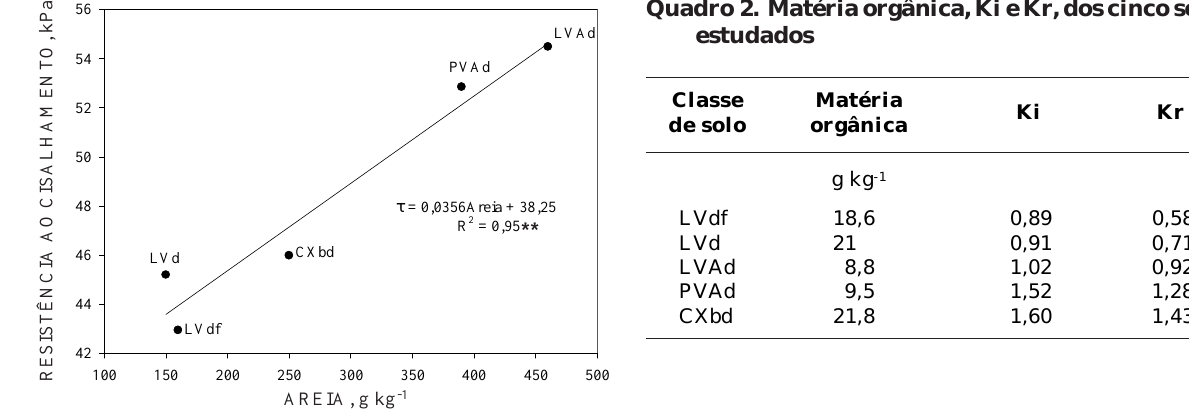
Figura 5. Variação da resistência ao cisalhamento dos solos com o teor de areia.